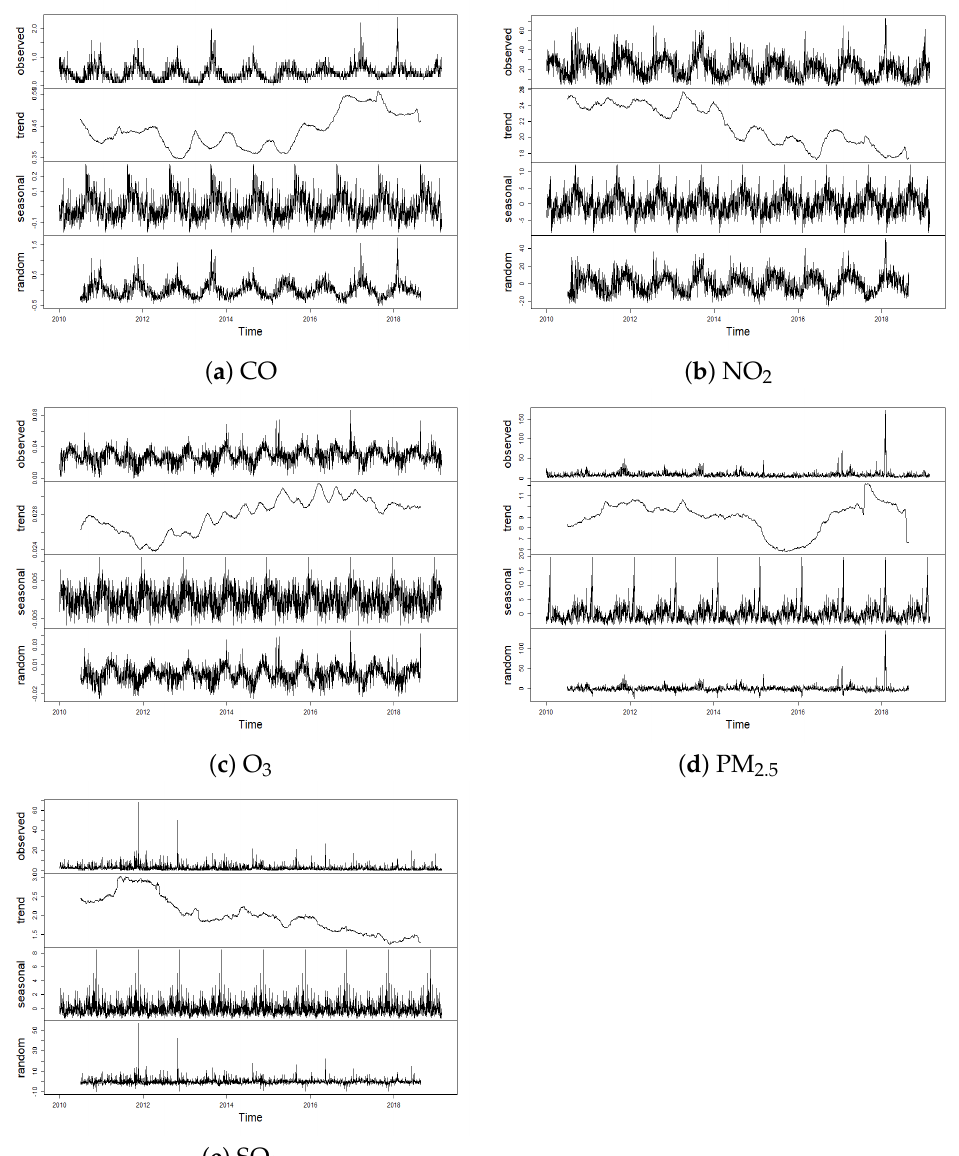
Figure 5. STL decomposition of air pollutant time